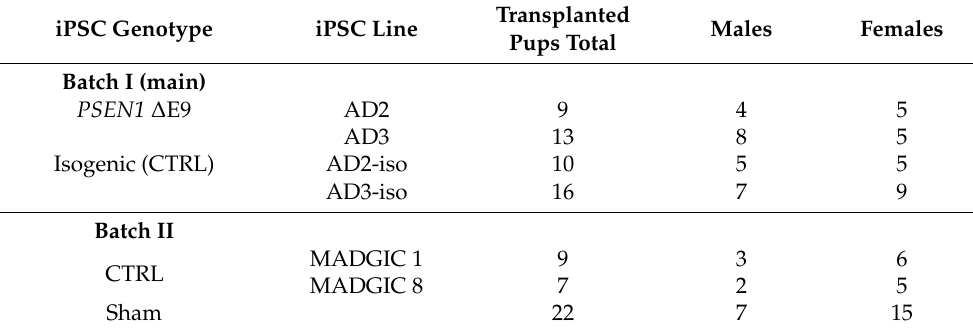
Table 2. Summary of the transplantations.